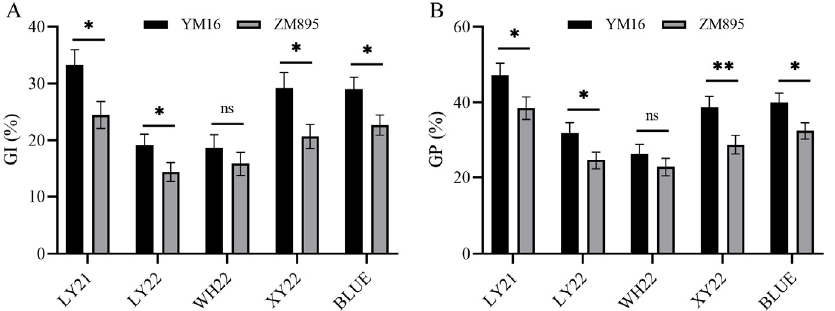
Figure 1. Effect of Qdor.hzau-3D.2 on GI ( A ) and GP ( B ) in the YM16/ZM895 double haploid population. YM16 and ZM895 represented alleles of Qdor.hzau-3D.2 from parent Yangmai16 and Zhongmai895, respectively; * p < 0.05; ** p < 0.01; ns, nonsignificant. Another four seed dormancy related QTLs were also detected in this study, and they were Qdor.hzau-2A , Qdor.hzau-4D , Qdor.hzau-5B and Qdor.hzau-5D (Table 3). However, each of the four QTLs could only be detected in one environment, indicating that they were not stable QTLs. Further experiments need to be done to confirm these QTLs. Table 3. QTLs for GI and GP detected by ICIM in the YM16/ZM895 DH population.